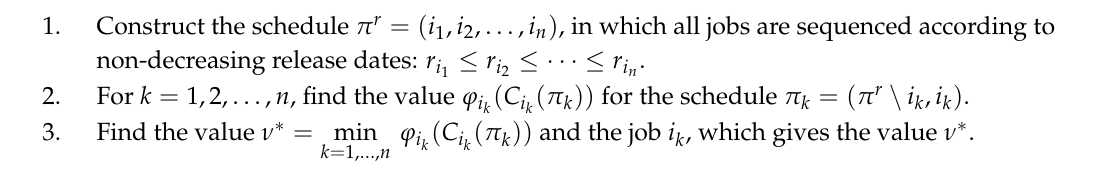
Algorithm 1: Solution of the dual problem of the problem 1 | r j | ϕ